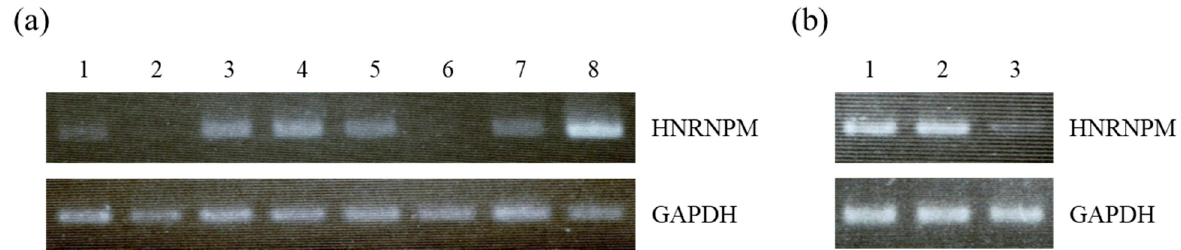
Figure 1. Expression of HNRNPM mRNA in various normal tissues, as well as normal and diseased pancreatic tissues. HNRNPM mRNA levels were determined by PCR. GAPDH mRNA expression served as a quantitative control. ( a ) Lane 1: heart, 2: brain, 3: placenta, 4: lung, 5: liver, 6: skeletal muscle, 7: kidney, 8: pancreas. ( b ) Lane 1: healthy subjects, 2: patients with diabetes, 3: pancreatic ductal adenocarcinoma (PDA) patients.